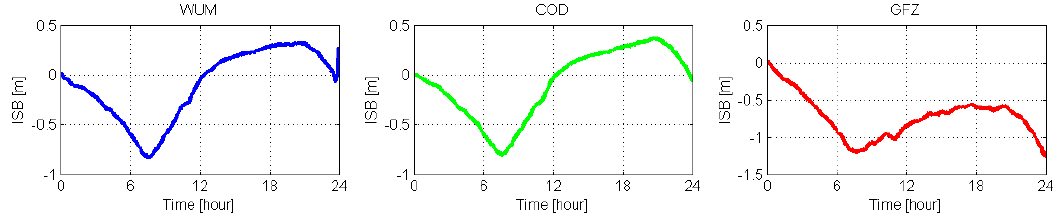
Figure 7. GPS / BDS ISB series of BALA WHU, CODE and GFZ precise products on DOY 002, Figure 7. GPS/BDS ISB series of BALA WHU, CODE and GFZ precise products on DOY 002, 2018.